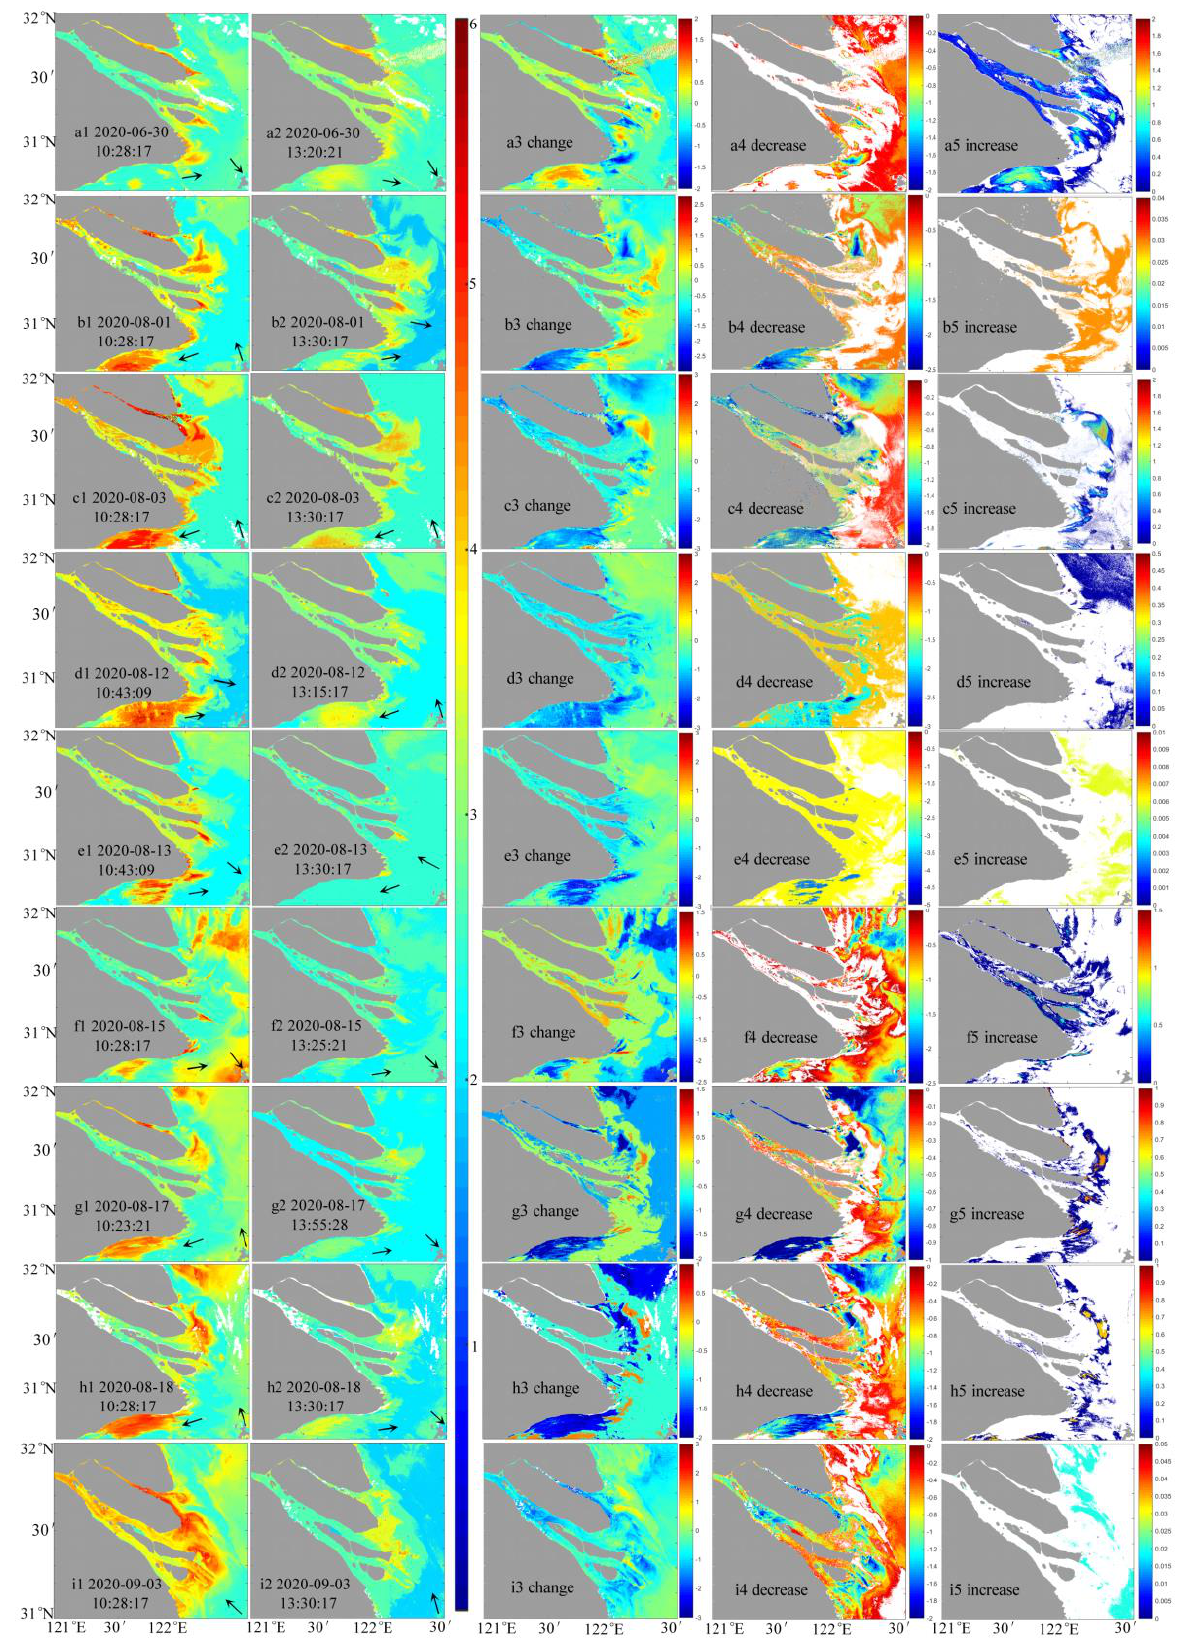
Figure 7. ( a1 – i1 ), ( a2 – i2 ), ( a3 – i3 ): Chl-a change in the same day ( a4 – i4 ): the decrease area of Chl-a.